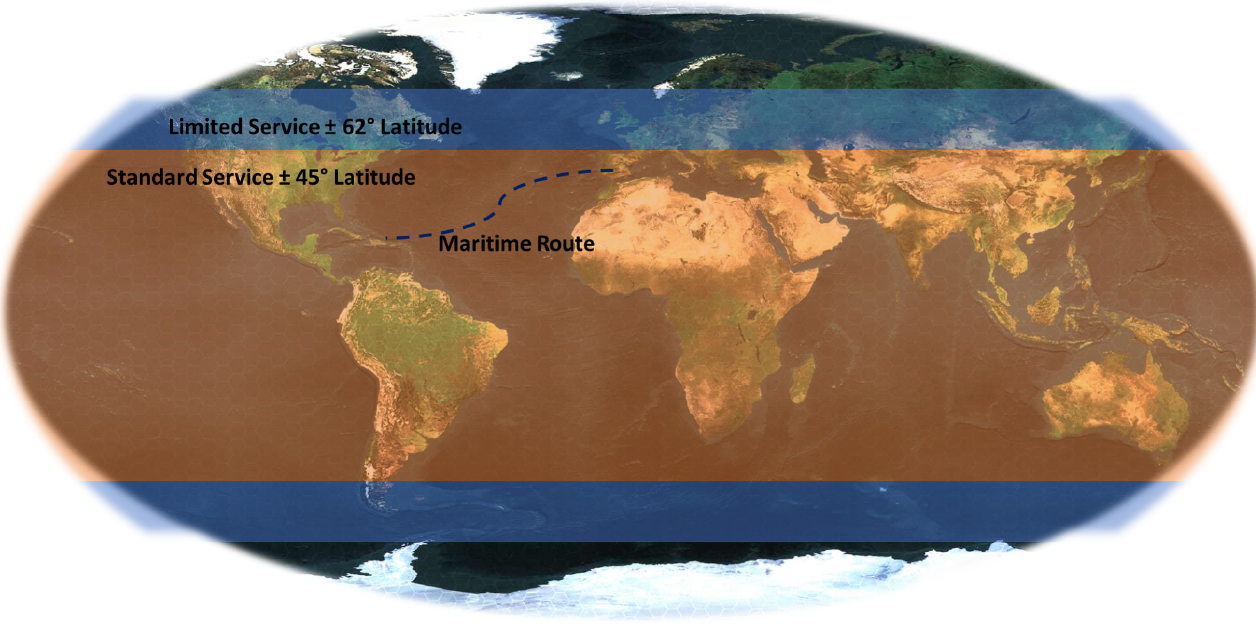
Figure 7. Maritime route and service